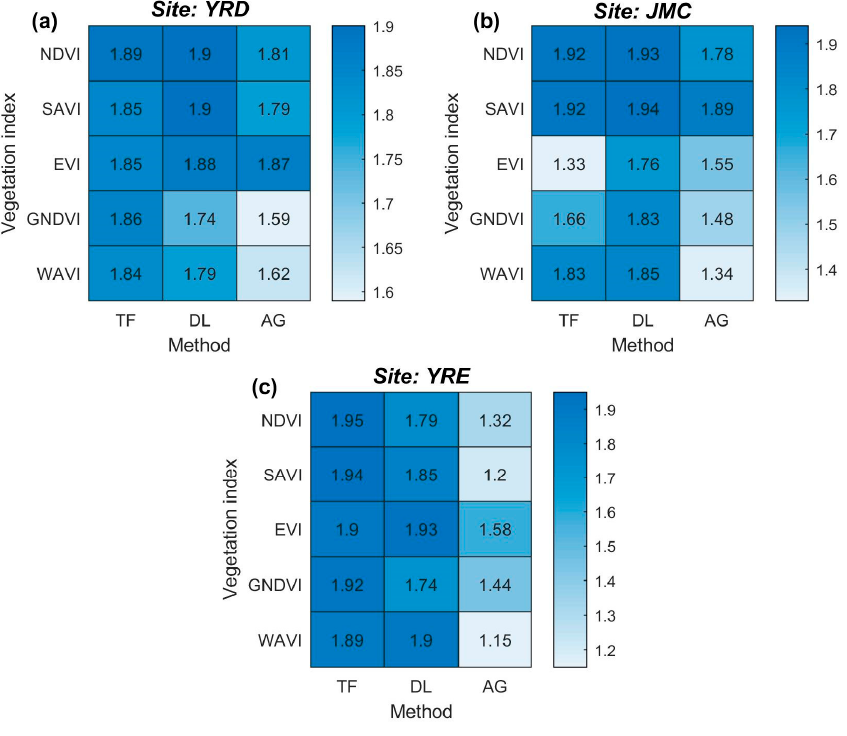
Figure 7. Salt marsh vegetation separability for the different VI time series-based curve fitting model measured by the overall Jeffries–Matusita distance (OJMD). (a–c) The OJMD for different VI time- series-based curve fitting models in the YRD, JMC, and YRE, respectively. Bluer cells equate to a higher degree of separability achieved by the model. Note: (i) the labeled value denotes the OJMD; and (ii) the curve fitting model, AG = Asymmetric Gaussian, DL = Double Logistic, and TF = Two- term Fourier.